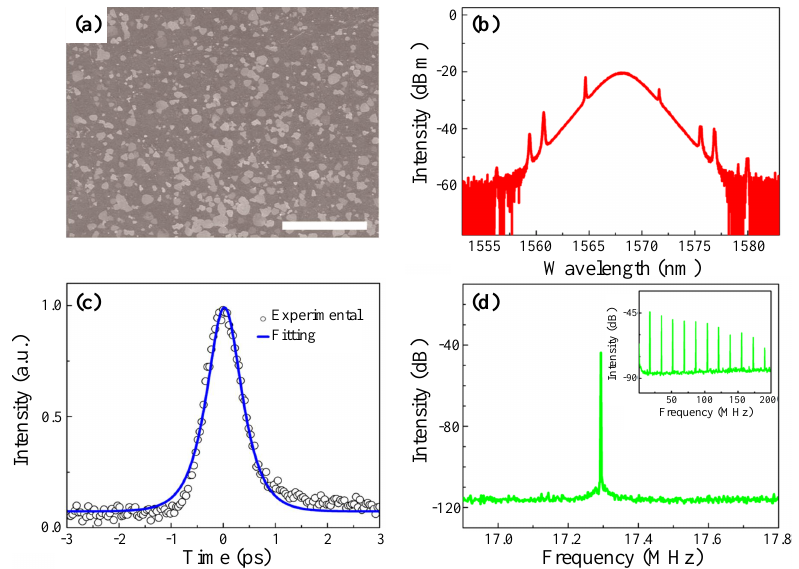
Figure 13. The experimental results of mode-locked fiber laser enabled by graphene/Bi 2 Te 3 het- erostructure SA. ( a ) SEM image of graphene/Bi 2 Te 3 heterostructure with 15% coverage of Bi 2 Te 3 . ( b ) Output spectrum. ( c ) Autocorrelation trace. ( d ) RF spectrum (insert: RF spectrum with a wideband up to 200 MHz). ( a – d ) adapted from